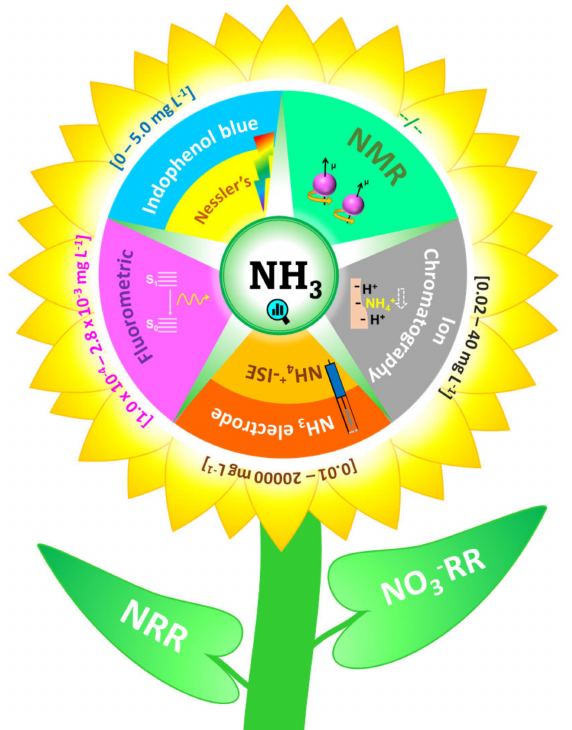
Figure 8. Illustration of five major quantification methods that have been used or can potentially be used for ammonia quantification in nitrogen/nitrate reduction